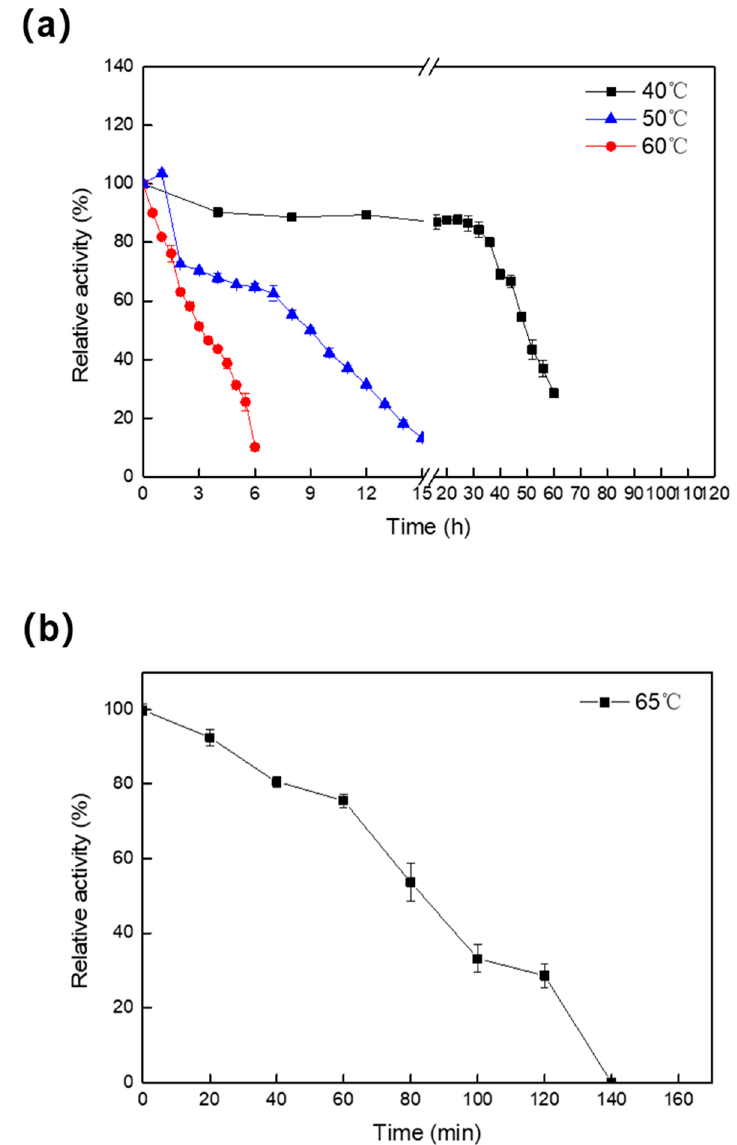
Figure 4. The thermostability of Melac13220 after incubation of the purified laccase at 40, 50 ◦ C, 60 ◦ C ( a ) and 65 ◦ C ( b ) with different durations. All the results represented as the means ± standard deviation from at least three independent experiments.